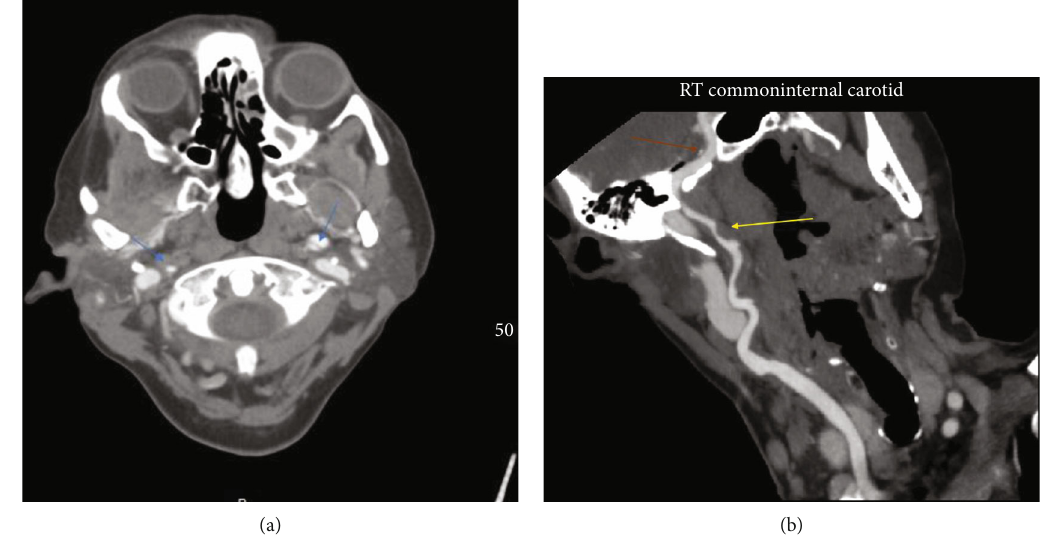
Figure 2: (a) Computed tomography angiography imaging showing the right and left common carotid artery dissection (blue arrows). (b) Computed tomography angiography imaging showing the right common (yellow arrow) and internal (red arrow) carotid artery dissections.